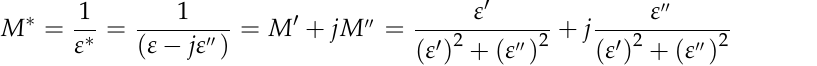
where M (cid:48) and M” are the real part and imaginary part of the complex dielectric modulus ( M* ), respectively [60]. Figure 8 shows the frequency dependence of the imaginary part of the modulus at different temperatures. In fact, the low frequency peak corresponds to the long-range migration of ions, whereas the high frequency peak represents spatially confined ions within potential wells and localized short distance motion within the domains [56]. The values of relaxation time τ = 1 corresponding to the frequency of the low- w max frequency maximum f max of the M” frequency spectrum are plotted in Figure 9 as a function of temperature. This follows an Arrhenius law with the activation energy Ea being 0.56, 0.69, 0.44 and 0.53 eV for pristine poly( p -phenylenediamine), PPDA-5, PPDA-35 and PPDA-50, respectively.